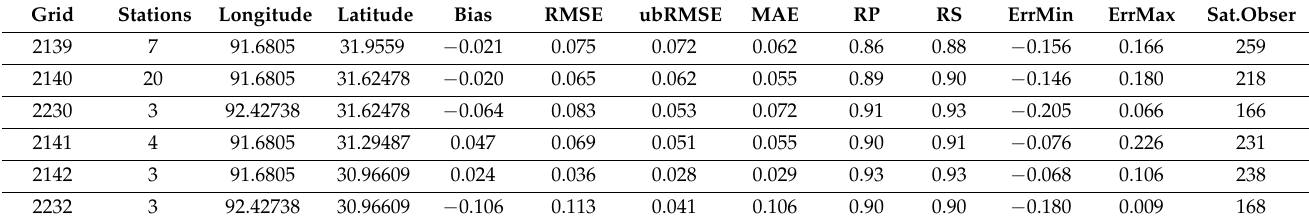
Table 1. Satellite (SPL3SMP_36km) and ground-measured SSM comparisons at the validation sites on the Tibetan Plateau, including all the datasets from 1 April 2015 to September 2016. Units are in m 3 /m 3 .